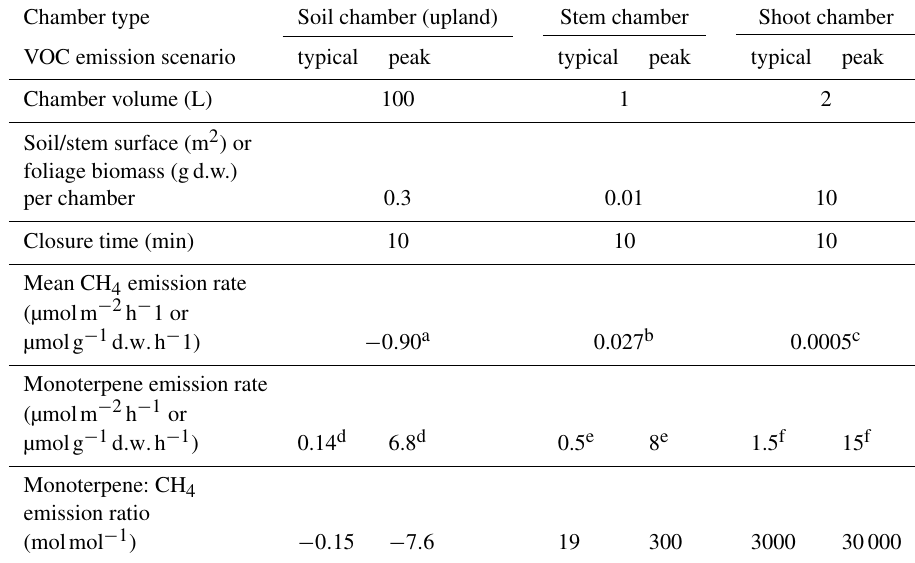
Table 1. Assumptions used to estimate VOC effects on CH 4 flux measurements in static soil, stem, and shoot chambers. Where available, assumptions are based on measurements conducted in the Scots pine forest at the SMEAR II research station (Hyytiälä,